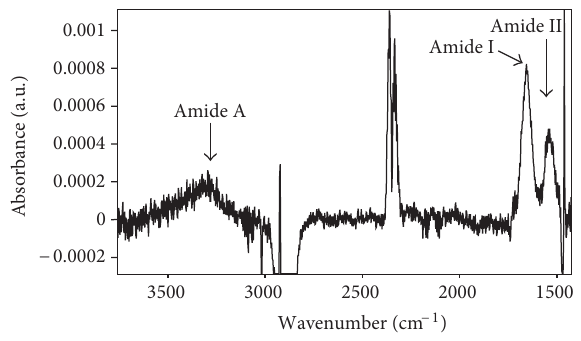
F 13: FTIR ATR spectra of attached HRP protein on LDPE. e spectra of LDPE is subtracted. ree main lines Amide A, I and II of protein are clear visible. e centre peak is CO spectrometer. e regions of polyethylene lines (2980–2820cm ) are noisy aer −1